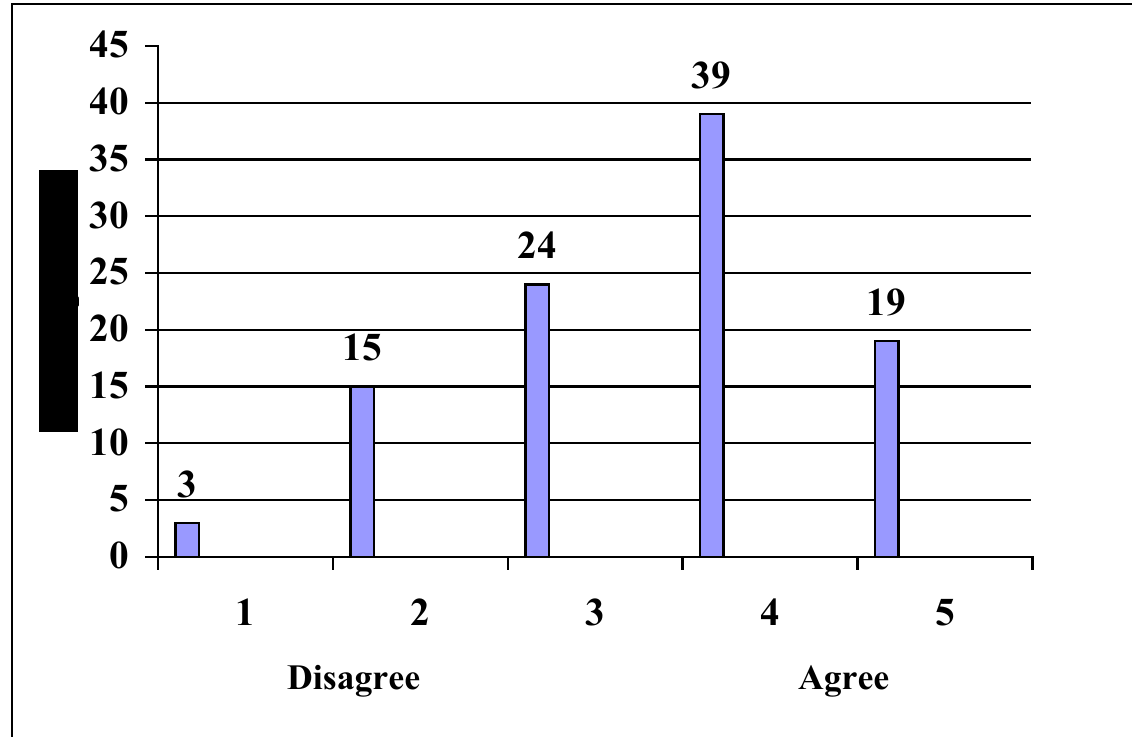
Figure 1 Histogram of the frequency distribution results of the role of training in managing organisational